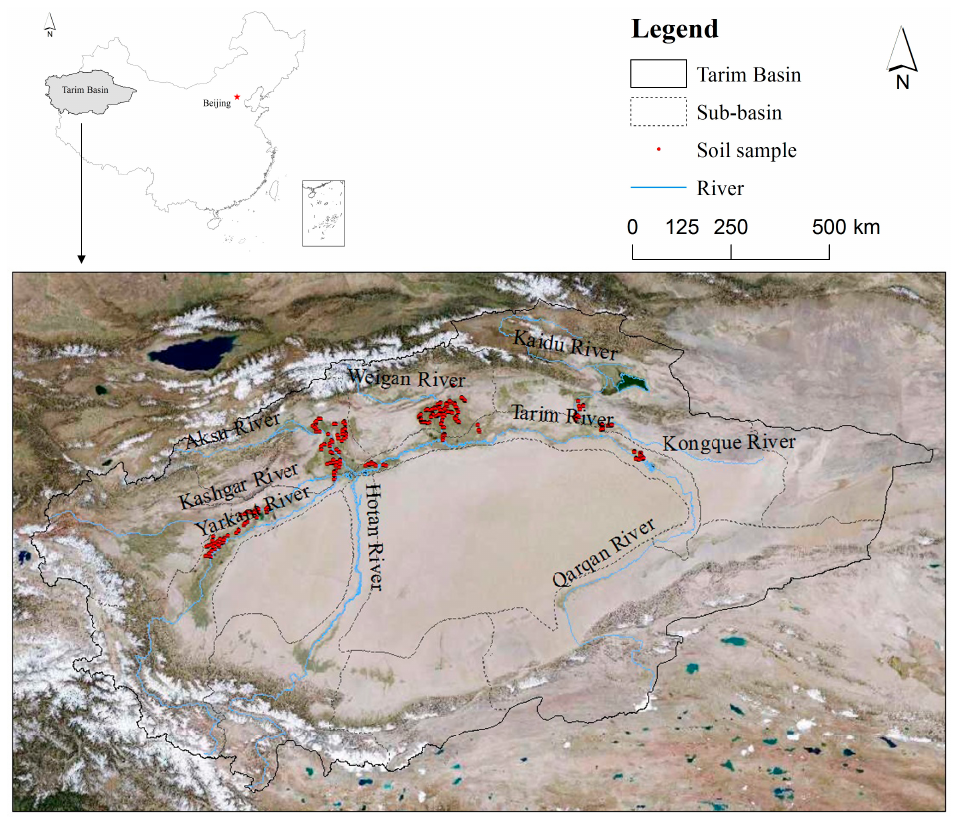
Figure 1. Location and soil sampling sites in the area of the Tarim Basin.